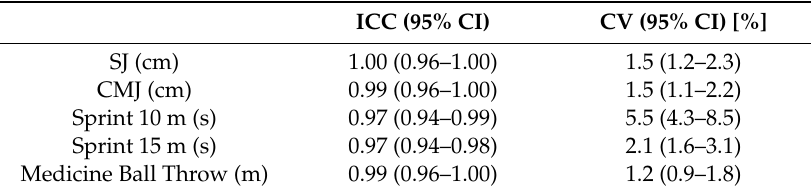
Table 1. Intraclass correlation coefficient (ICC) and coefficient of variation (CV) for performance measures. Data were collected two weeks apart and thus represent between-day reliability. CI: confidence interval; SJ = squat jump; CMJ = countermovement